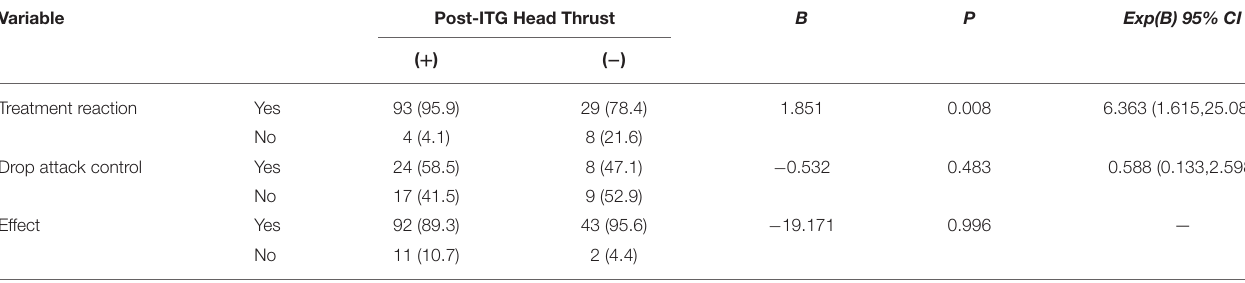
TABLE 3 | Comparison of treatment response in patients who did and did not convert to head thrust ( + ) after ITG. (%)*. Variable